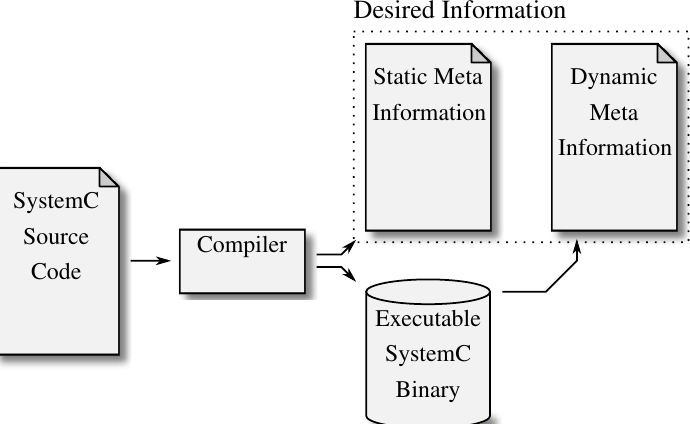
Figure 4. Hybrid approaches split the analysis into two parts. First, the static information is extracted from or by the compiler, which is translating the program anyway. Second, the executable file generated by the compiler is executed, and the dynamic information (esp.SystemC object instances) is extracted from the running